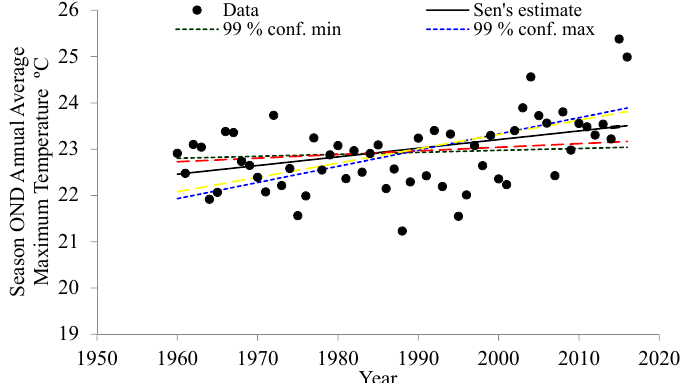
Figure 7. Mann–Kendall and linear regression slopes of season, October–December (OND), annual average maximum temperature for Maloti-Drakensberg for the period of 1960–2016.